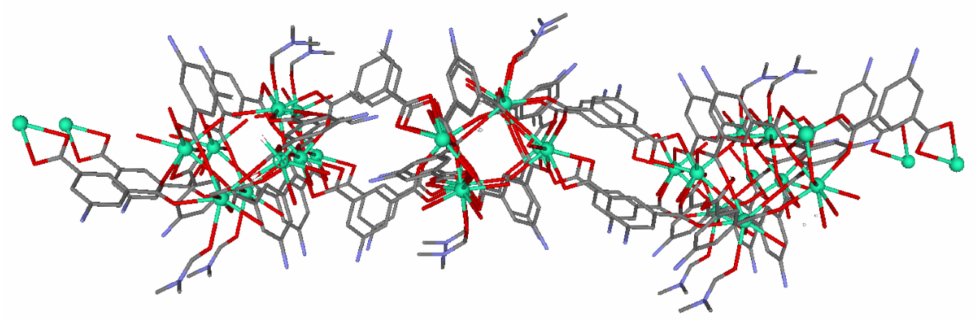
Figure 1. The two-dimensional structure of compound 1 . Crystallization molecules and hydrogen atoms are omitted for clarity. Color code: C = gray, Dy = green, N = blue, O =